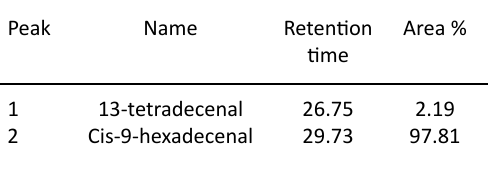
Table 2. Chromatographic profile of cis-9-hexadecenal